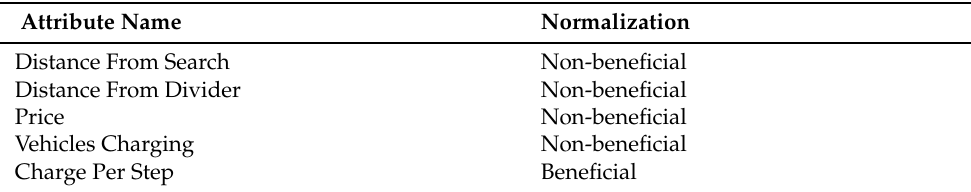
Table 2. Charging station attributes for SAW